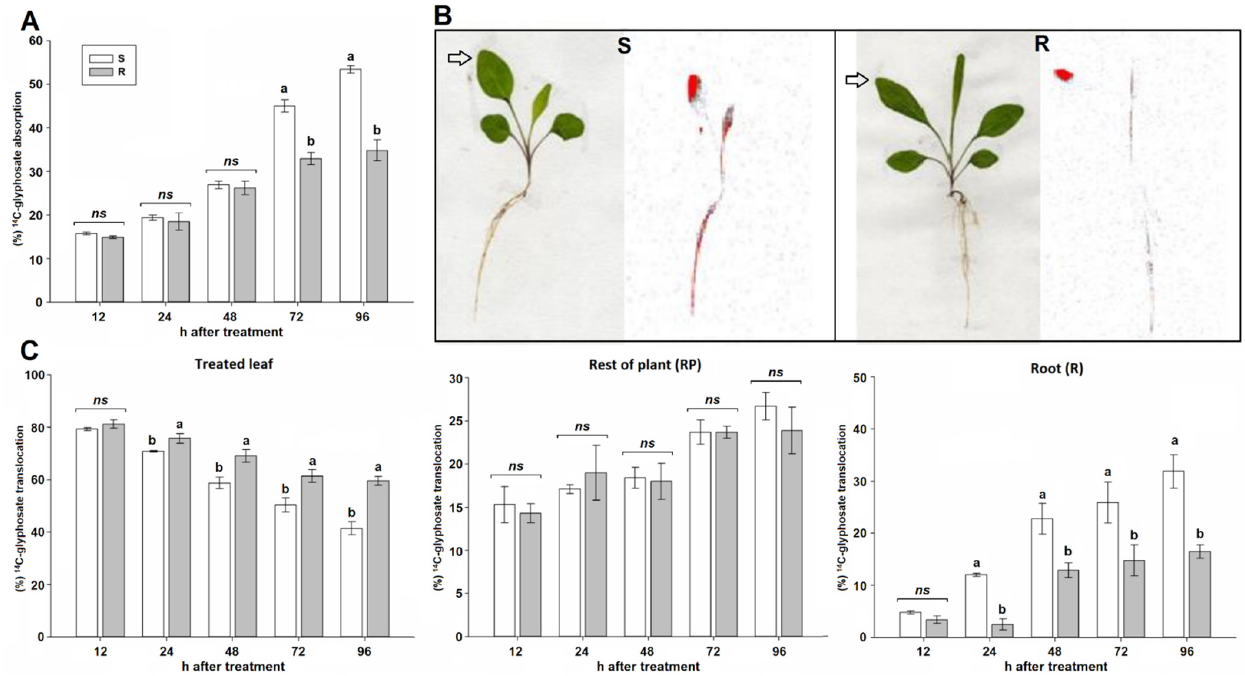
Figure 4. Absorption and translocation of 14 C-glyphosate in susceptible (S) and resistant (R) saltmarsh aster ( A. squamatus ) populations from 12 to 96 h after treatment (HAT). ( A ) 14 C-glyphosate absorption (% from the total applied). ( B ) Digital (on the left) and autoradiograph (right) images illustrating the 14 C-glyphosate distribution within plants at 96 HAT. Red regions show higher signal (concentration) of 14 C. ( C ) 14 C-glyphosate translocation (% of the recovered) from the treated leaf to the rest of the plant, and roots. Vertical bars represent the standard error of the mean ( n = 5). ns, no significant and different letter denotes differences between populations within an evaluation time by the Tukey test ( p < 0.05).